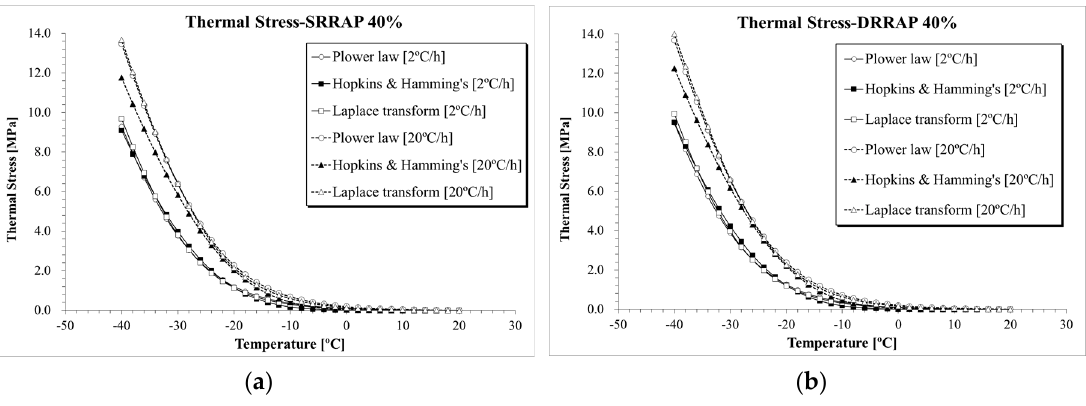
Materials 2020 , 13 , x FOR PEER REVIEW Figure 11. σ ( T ) computation results: ( a ) SRRAP 25% mixture; ( b ) DRRAP 25% mixture.